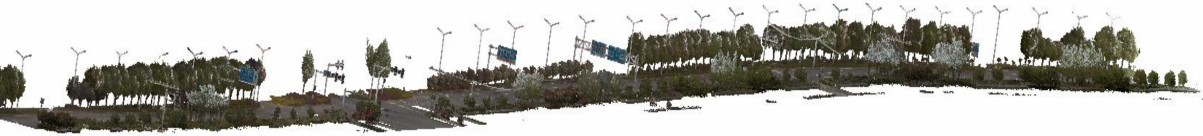
Figure 2. Road points cloud data.